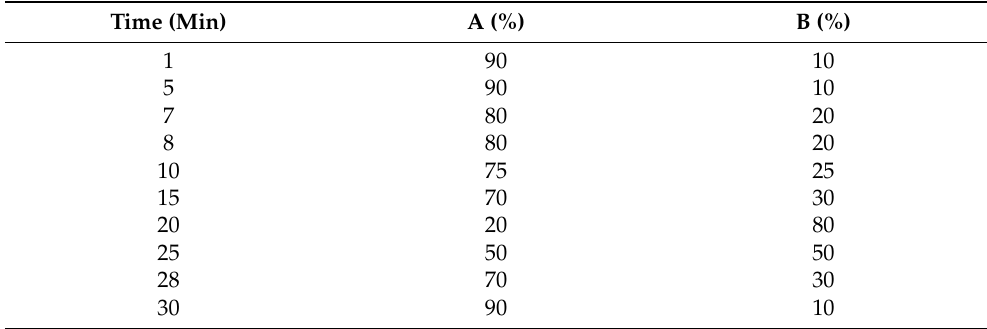
Table 2. The mobile phase